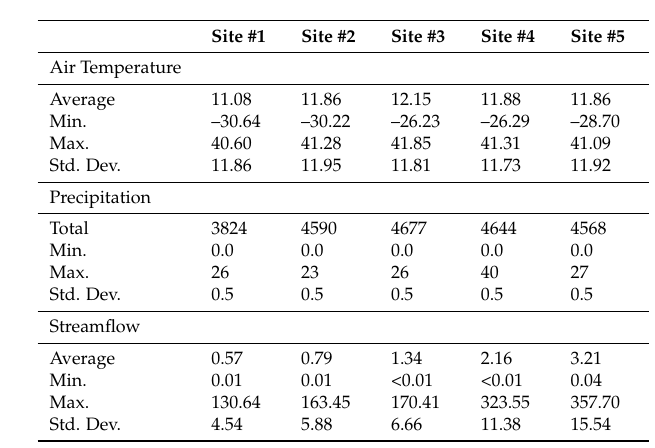
Table 3. Descriptive statistics for 30-min. precipitation (mm), streamflow (m 3 sec − 1 ), and air temperature ( ◦ C) at each gauging site ( n = 5) during study period (October 2010–May 2014) in Hinkson Creek Watershed, MO, USA [43].